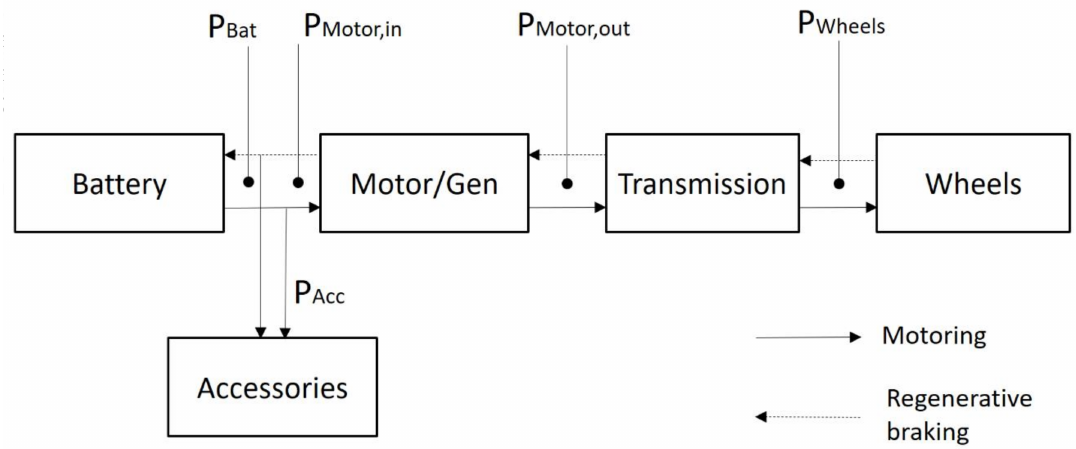
Figure 1. Block diagram of the power flows in the components of the electric vehicle